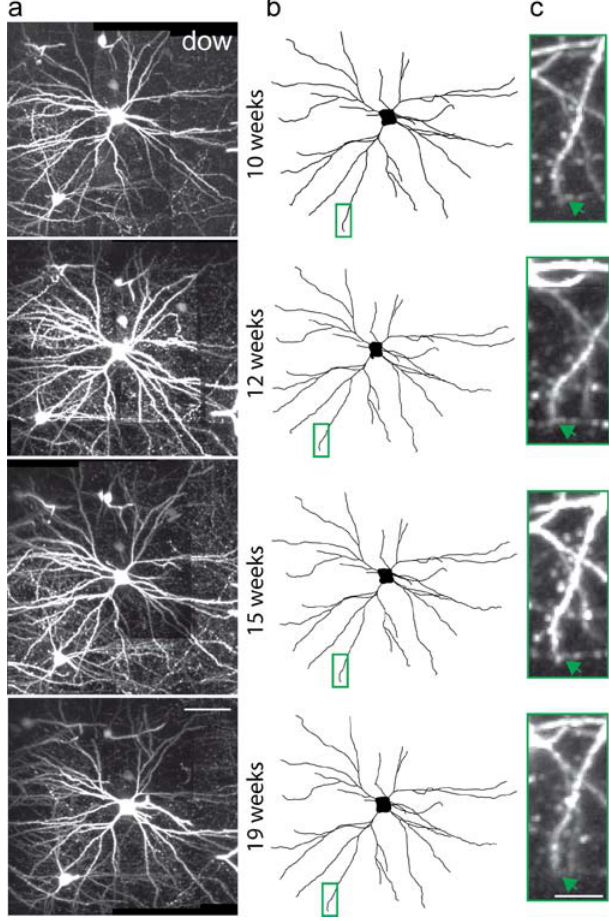
Figure 2. Dendritic Arbors of Pyramidal Neurons Are Stable (A) MZPs near the cell body of the pyramidal cell ‘‘ dow ’’ acquired over 9 wk. (B) Two-dimensional projections of three-dimensional skeletal recon- structions of ‘‘ dow. ’’ (C) High-magnification view of branch tip (green arrow) in region outlined by green box in (B). Scale bars: (A and B), 50 l m; (C), 10 l m. DOI: 10.1371/journal.pbio.0040029.g002